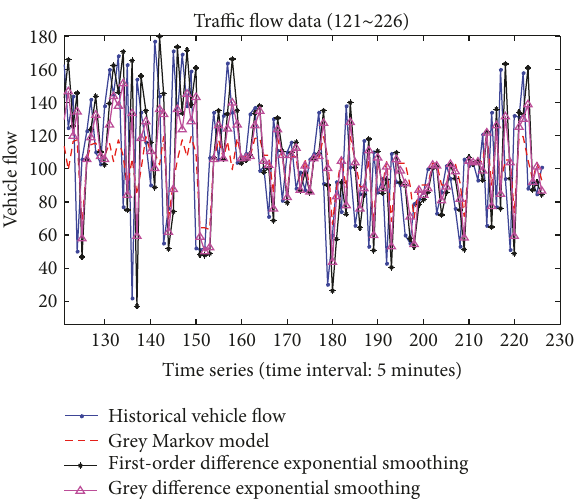
Figure 9: Fitting curves between model predictive values and actual test values (the latter 106 data